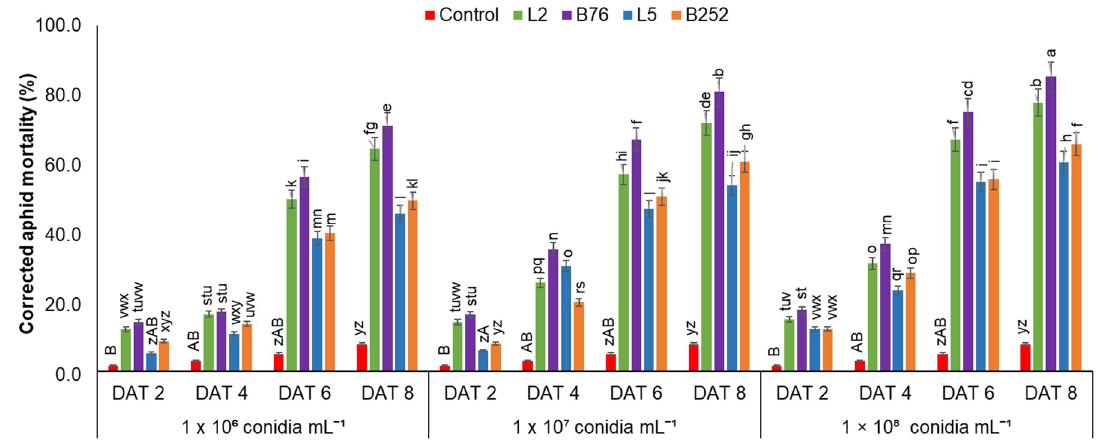
Figure 1. The mortality of Megoura japonica by different concentrations of Verticillium lecanii (L2 and L5) and Beauveria bassiana (B76 and B252) spores at different time intervals. Columns show the mortality of aphids with different fungal strains ± SE ( n = 50). The different letters express significant differences between different treatments (three‐way factorial analysis of variance (ANOVA); least significant difference (LSD) test at α = 0.05). DAT: Days after treatment. Table 1. Analysis of variance (ANOVA) for the mortality of M. japonica by three different concentrations from four entomopathogenic fungi strains at different times against bean aphids.